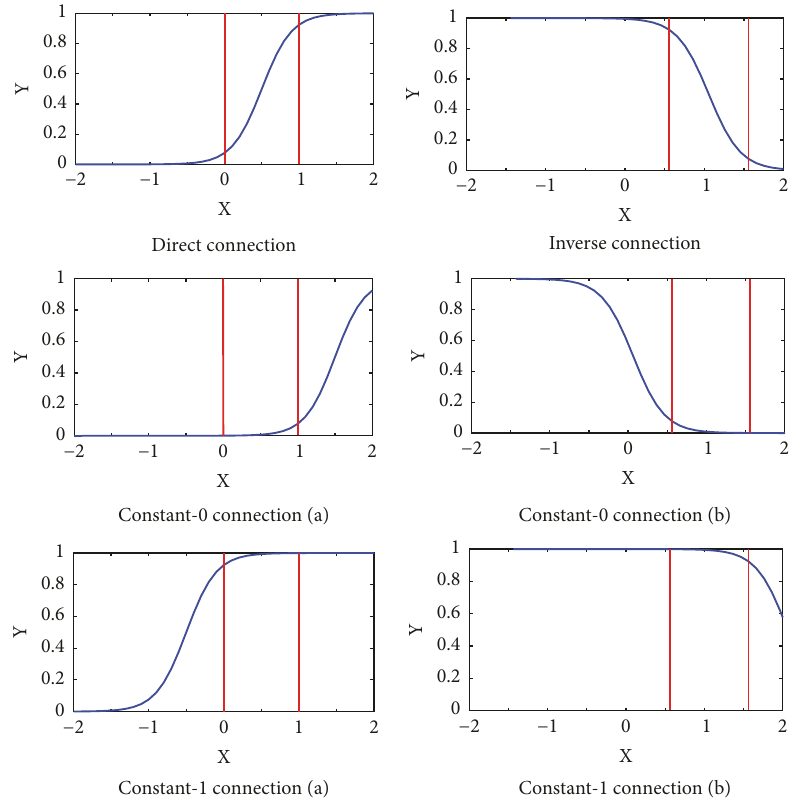
Figure 2: Six connection cases of the synaptic